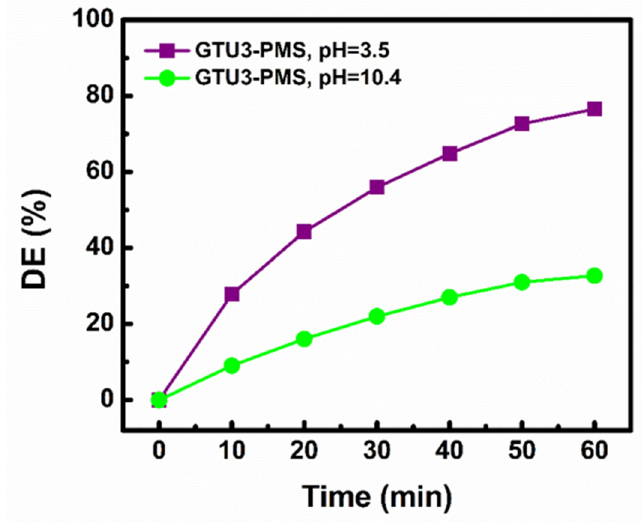
Figure 8. Catalytic degradation e ffi ciency of GTU-3 at pH = 10.4, [RhB] 0 = 10 mg/L (50 mL), [PMS] = 0.5 mM, and GTU-3 = 0.4 g/L.